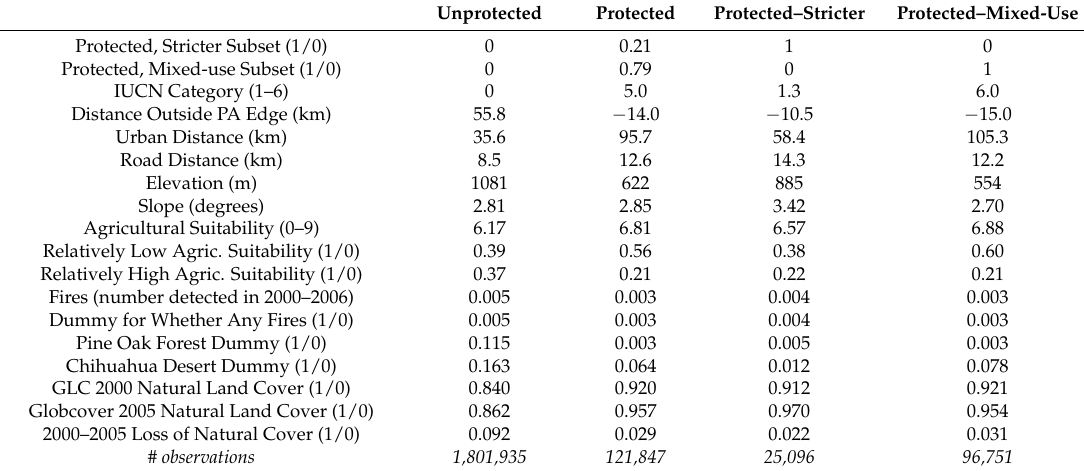
Table 1. Land characteristics and land cover (including PA